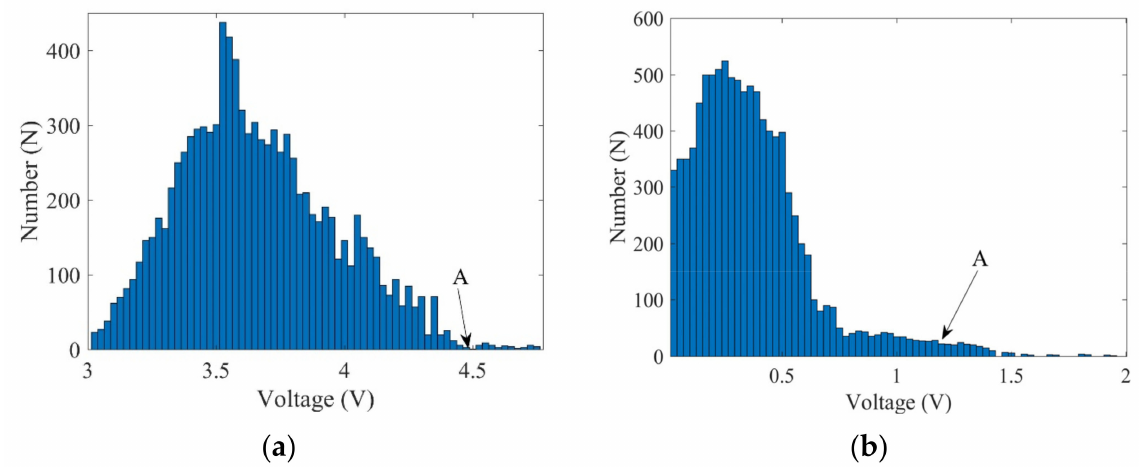
Figure 9. Statistical results obtained for wave voltage amplitudes at ( a ) 22 µ s and ( b ) 29 µ